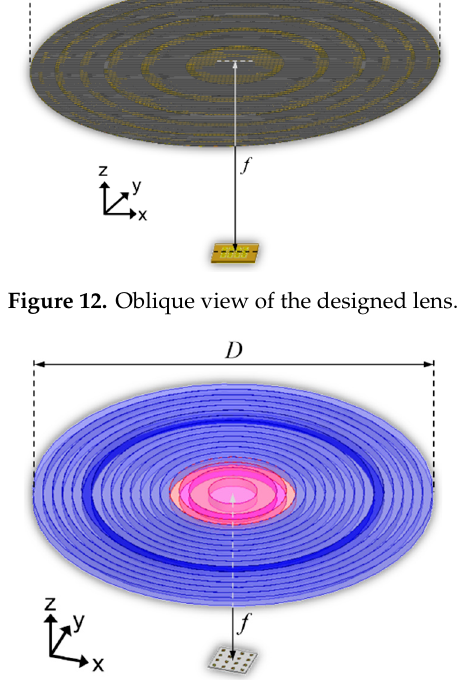
Figure 13. Oblique view of designed lens where the unit cells are replaced by effective mediums to expedite simulation time.